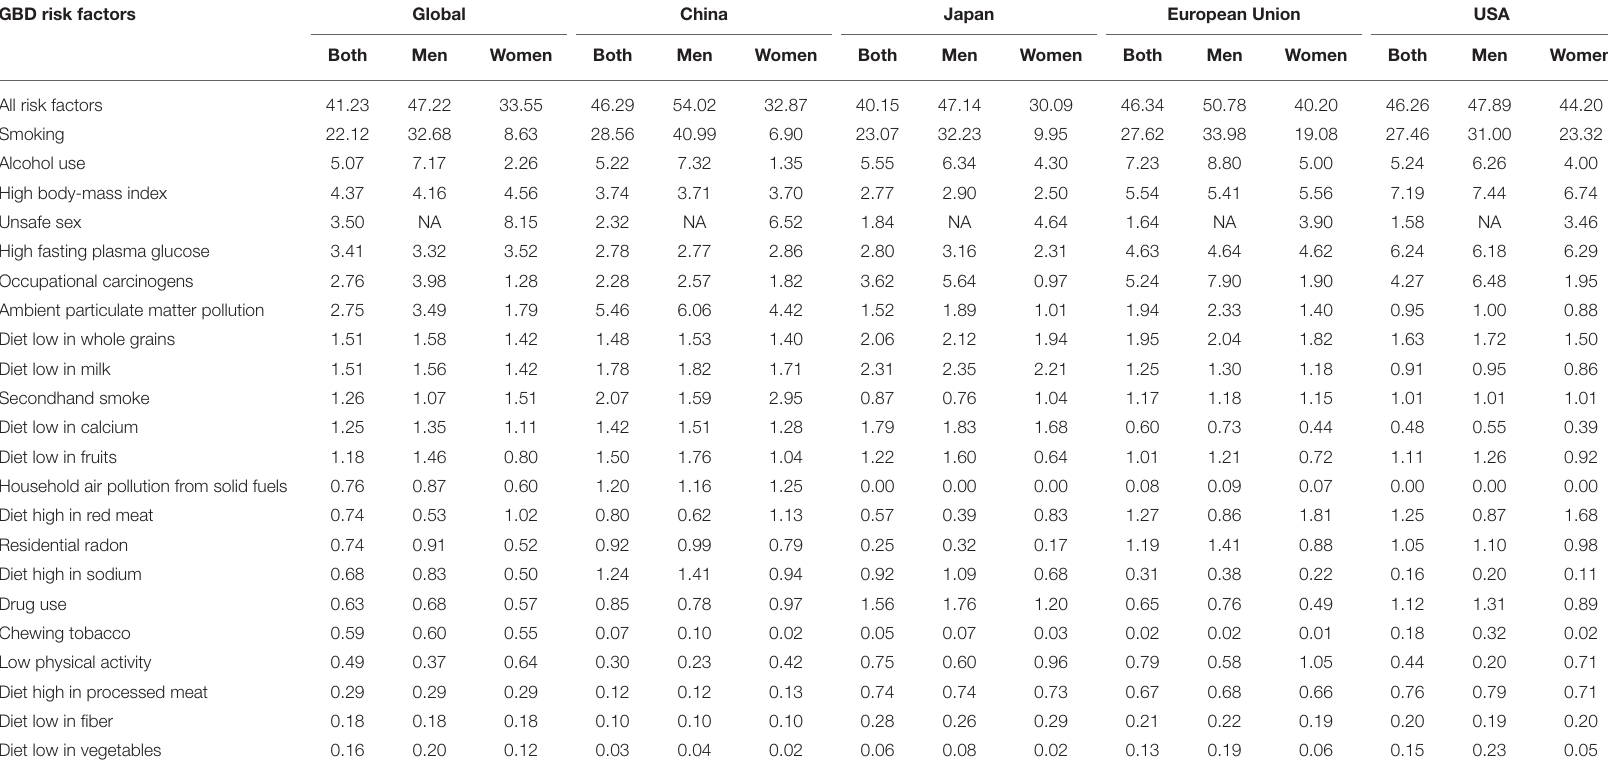
TABLE 2 | The proportion (%) of overall neoplasms DALYs attributable to risk factors in the world, China, Japan, European Union, and USA, 2019, stratified by